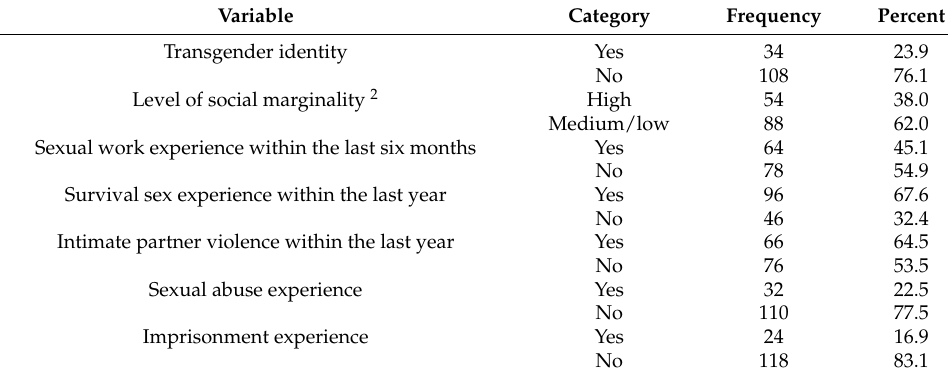
Table 4. Exposure to psychosocial stressors 1 of the interviewed men who have sex with men, Manzanillo, Mexico.